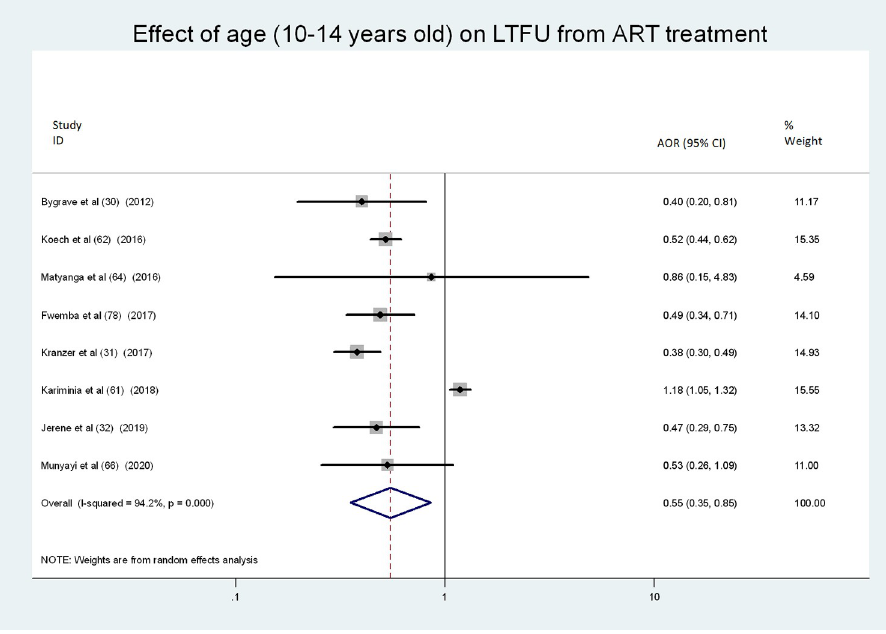
Fig 7. Forest plot showing the association of age and LTFU in ART treatment.